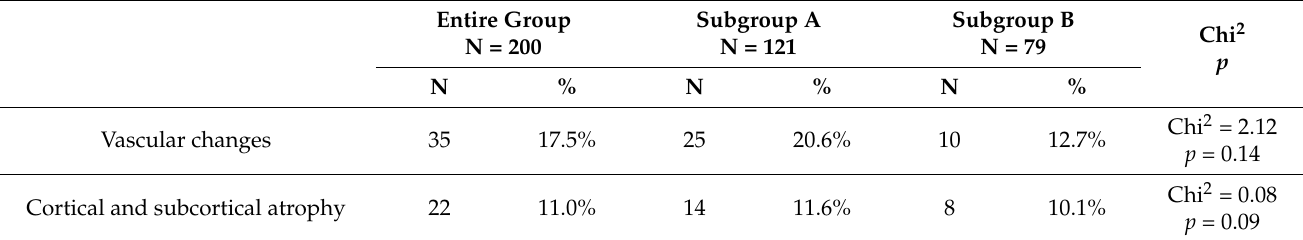
Table 7. Described vascular changes as well as cortical and subcortical atrophy in specific subgroups of HIV-positive patients.